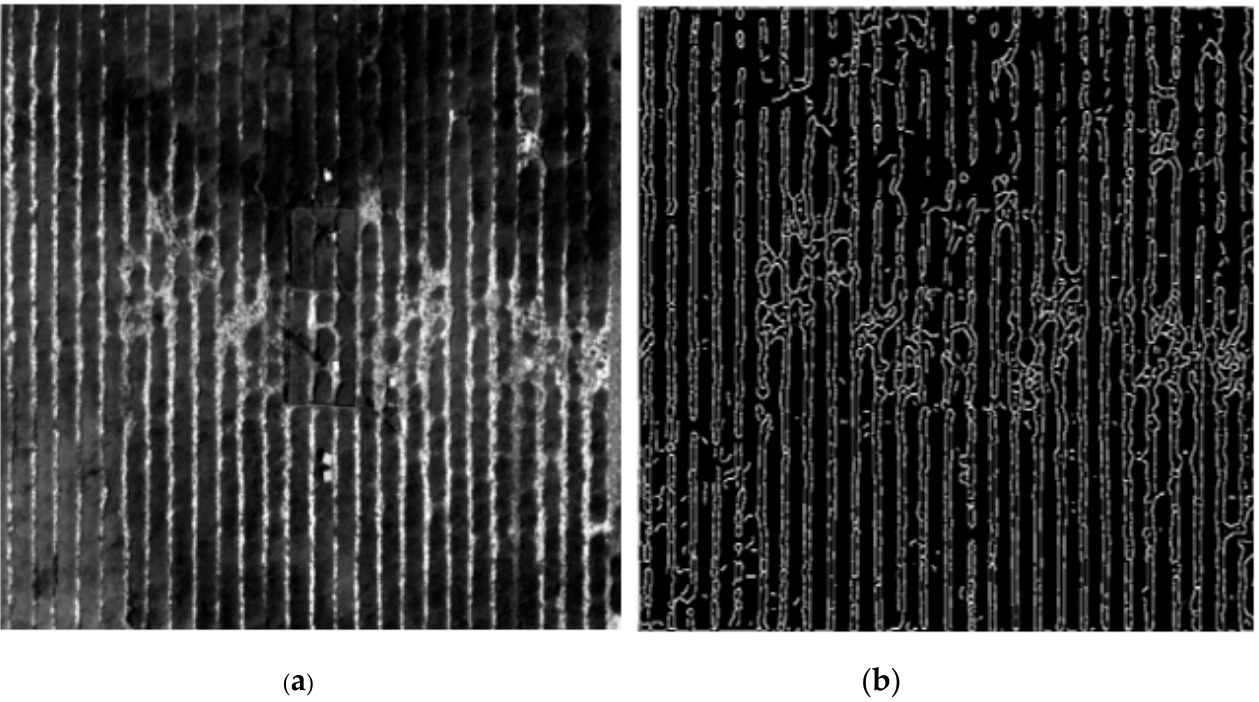
Figure 4. The UAV of study area, ( a ) raw thermal image, ( b ) raw image after twice filtering.